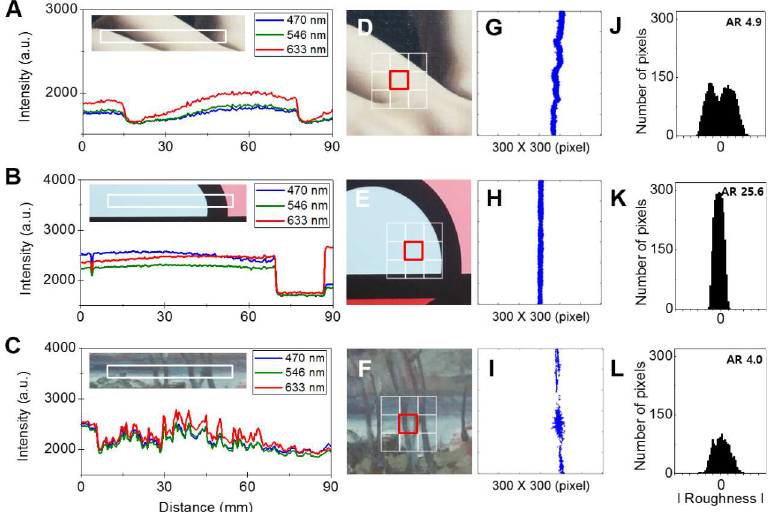
Fig 7. Measurement data for creating the database. (A), (B) and (C) are the measuredRGB color spectra of the paintingsin the white boxes. (D), (E) and (F) present parts of the artworks. The red boxesindicatethe scannedregions;(G), (H), and (I) are the obtainedtopographic imagesusingthe thresholdprocess(300 × 300 pixels); (J), (K) and (L) are the numbersof pixels alongroughnessand presented with the ARs.